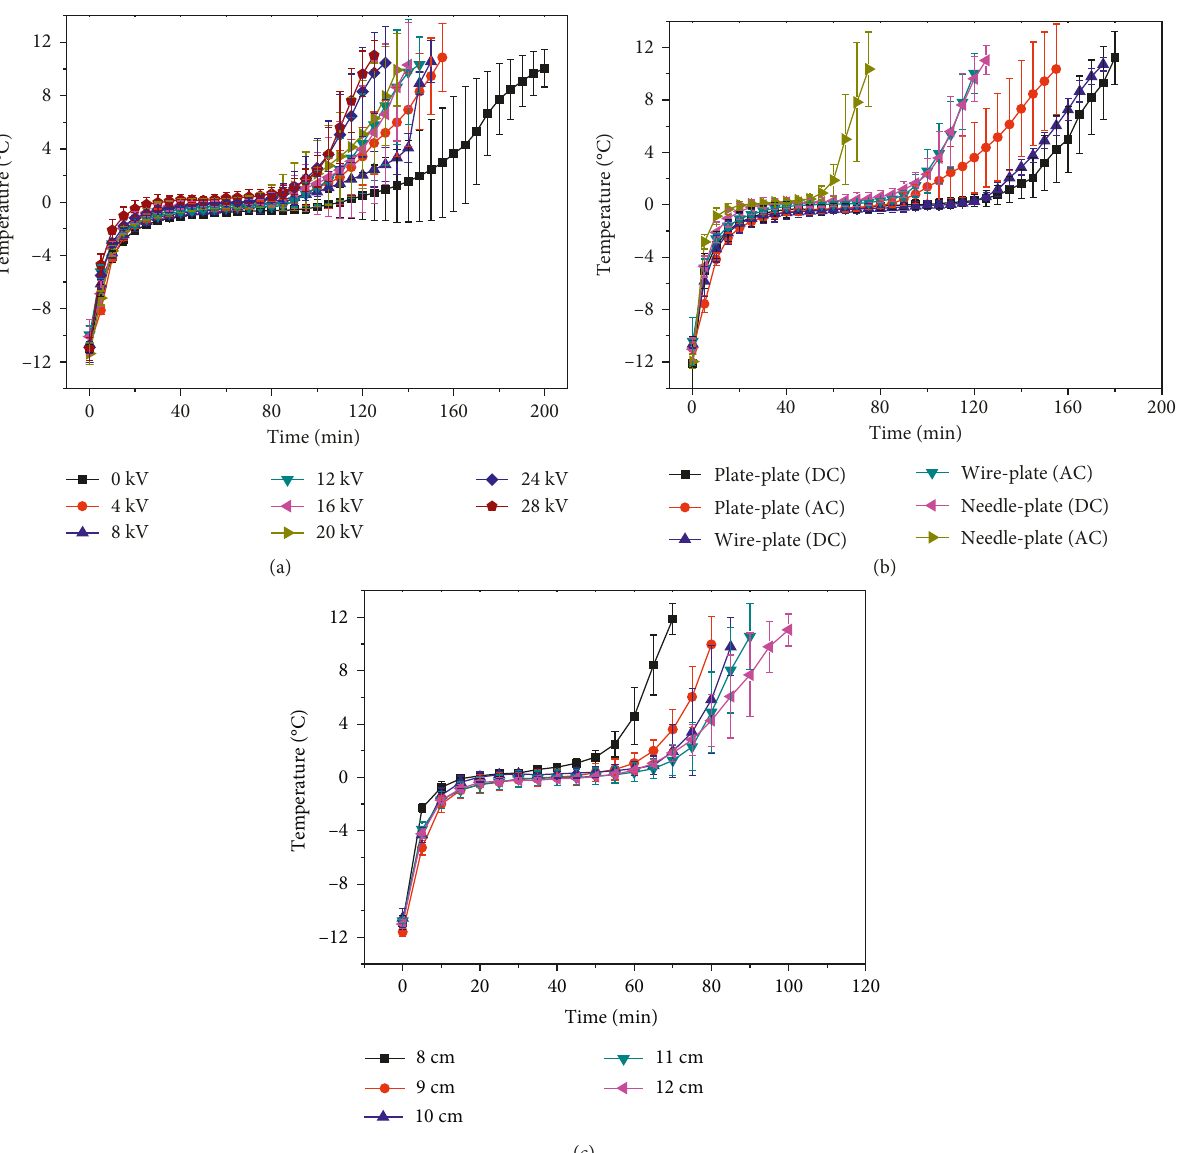
Figure 3: (a) Changes in temperature during thawing of frozen tofu in different voltages. The frozen tofu was thawed at 20 ° C with a fixed discharge gap of 100mm under DC electric field. The thawing voltage was 0kV (the control samples), 4kV, 8kV, 12kV, 16kV, 20kV, 24kV, or 28 kV, respectively. (b) Changes in temperature during thawing of frozen tofu in different electrodes. The corresponding discharge gap between the high-voltage electrodes and the grounded electrode was 100mm. The corresponding voltage was 28kV. (c) Changes in temperature during thawing of frozen tofu in different electrode distances. The discharge gap was 8cm, 9cm, 10 cm, 11cm, and 12cm with multiple needles-to-plate electrode for AC electric field, respectively. The corresponding voltage was